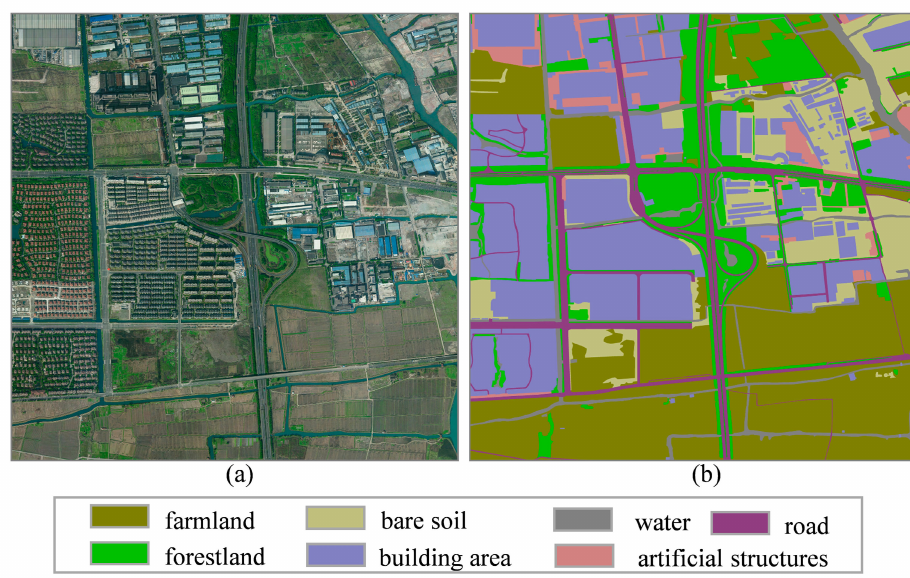
Figure 6. Examples of Shanghai dataset. ( a ) Aerial image; ( b ) corresponding ground